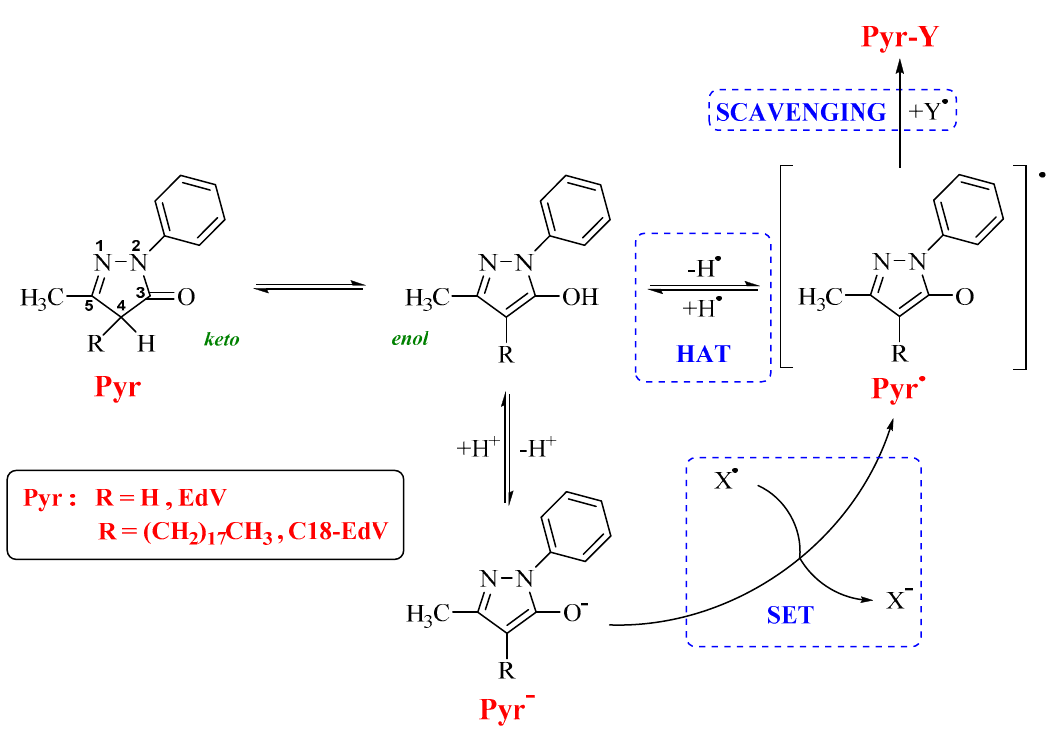
Figure 1. Edaravone 3D structure ( A ) and 2D structure ( B ).